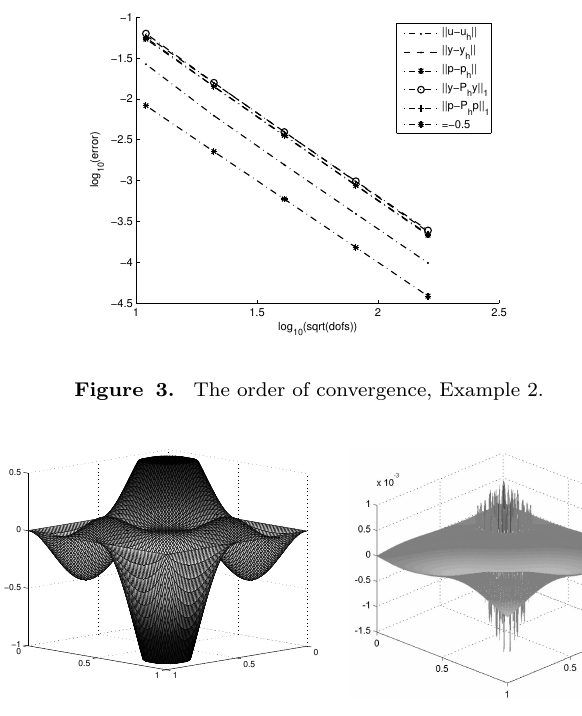
superconvergence of the second-order. Our analysis for the semilinear